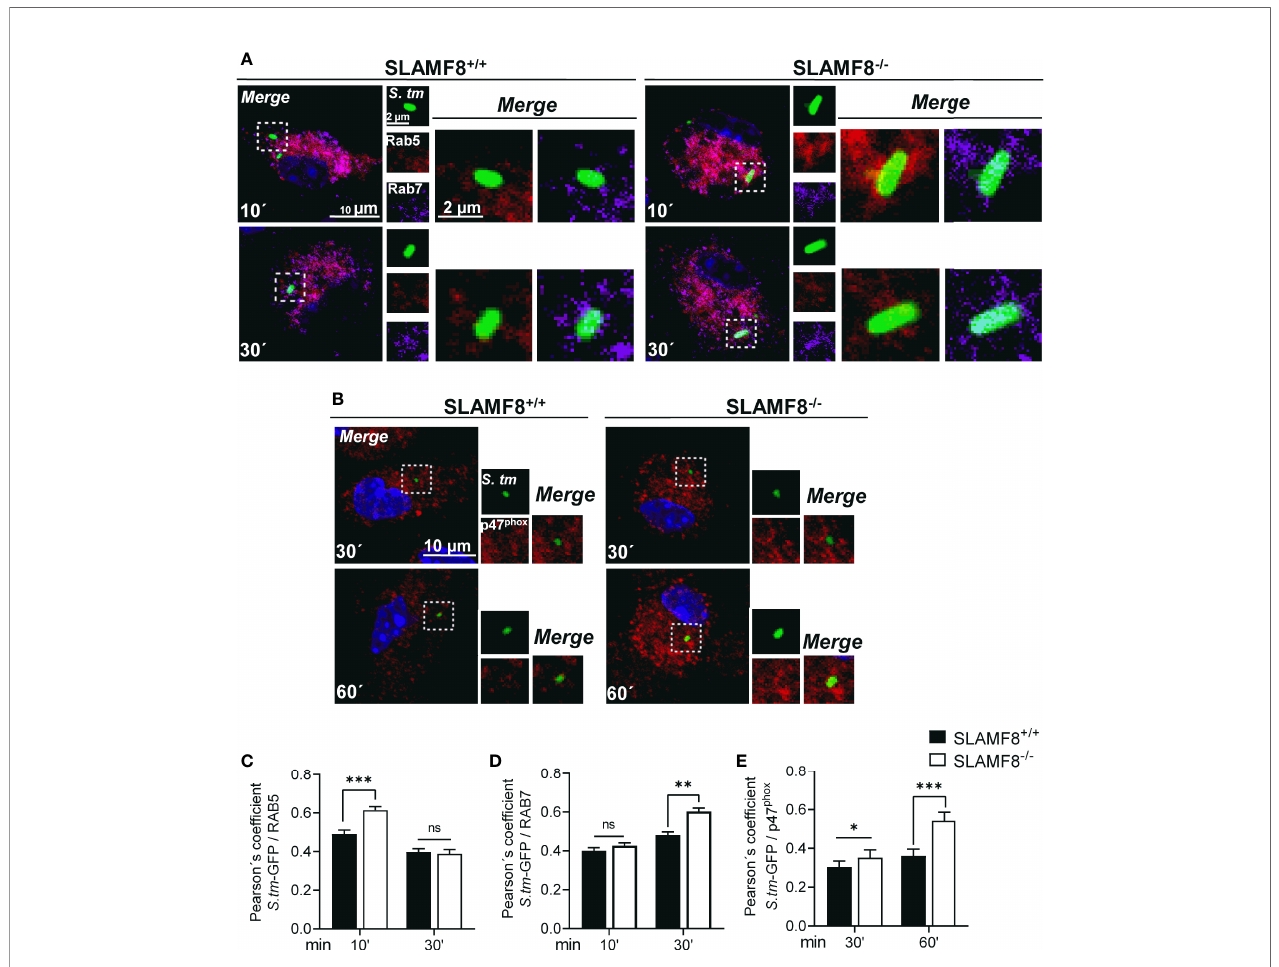
FIGURE 6 | SLAMF8 -/- pM f show increased transport of Rab5, Rab7, and p47 phox to SCV compartment compared to SLAMF8 +/+ pMø. Analysis of pMø infected with wild-type S. typhimurium -GFP (MOI 10) at different chase times and stained with antibodies against Rab5 (red), Rab7 (purple), and p47 phox (red). Nuclei were stained with DAPI. Representative confocal images of high-magni fi cation views from z-stacks (merge) and maximum projection of each parameter (small square pictures) are shown. Scale bars are indicated. Colocalization of proteins with S. typhimurium -GFP was determined by the Pearson ’ s correlation coef fi cient. Analyses were performed using the Nikon software. (A) Representative pictures of Rab5 (red) and Rab7 (purple) are shown (C, D) . Graphs show colocalization of Rab5 and Rab7 with S. typhimurium -GFP in SLAMF8 +/+ and SLAMF8 -/- pMø. *Indicates statistical signi fi cance between samples (* p <0.05, ** p < 0.01, *** p < 0.001). (B) Representative pictures of p47 phox (red) and S. typhimurium -GFP in SLAMF8 +/+ and SLAMF8 -/- pMø (E) . Colocalization of p47 phox (red) and S. typhimurium -GFP in SLAMF8 +/+ and SLAMF8 -/- pMø. *Indicates statistical signi fi cance for p47 phox between samples (*** p < 0.001). Values in the graph indicate the Pearson´s coef fi cient ± SEM ( n = 50 stochastic cells per coverslip). Results of one out of three independent experiments are shown. ns, not Signi fi